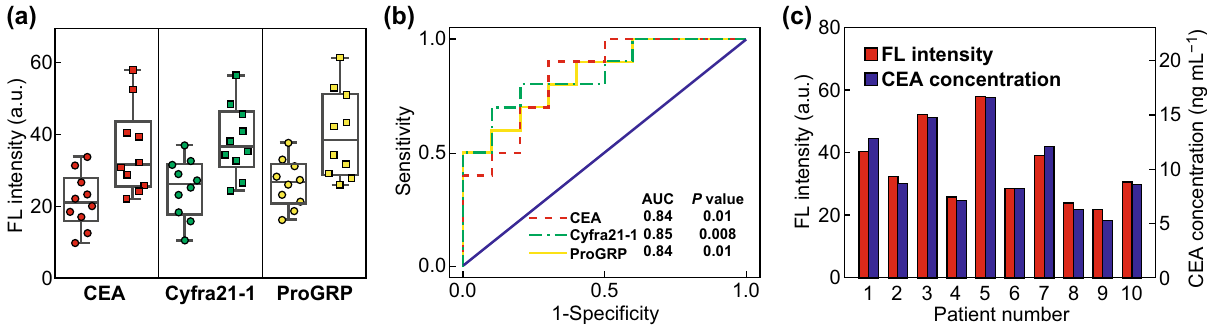
Fig. 5 a Box–whisker plots with scattering points indicating the expression levels of the three tumor markers from clinical plasma-derived exosomes, lung cancer patients (squares), and healthy controls (circles). b ROC curves of the multiplexed detection of three lung cancer exo- some markers (CEA: AUC = 0.84, p = 0.01; Cyfra21-1: AUC = 0.85, p = 0.008; and ProGRP: AUC = 0.84, p = 0.01). The confidence interval was 95%. c Comparison of clinical data of blood CEA concentrations with exosome CEA expression levels detected using our